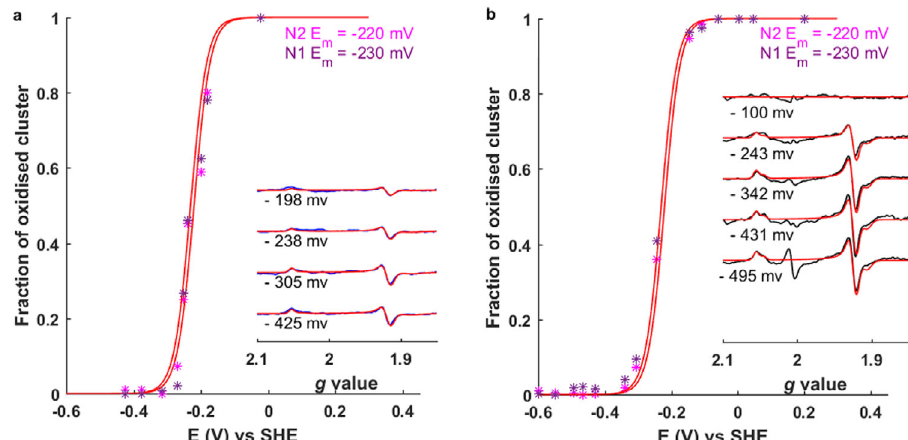
Fig. 3 The reduction potentials of PS-CI N2 and N1. Small-volume potentiometric titrations of PS-CI (Photosynthetic complex I) from a Synechocystis and b T. elongatus. The fraction of oxidised cluster (N2 or N1) was determined from the integration of the simulated continuous wave EPR spectra (insets, simulations in red) normalised against fully reduced N2 or N1. Data points were fi tted with the one-electron Nernst equation using the indicted midpoint potentials ( E m ). The g ~2 signal likely originates from the redox mediators required to perform the